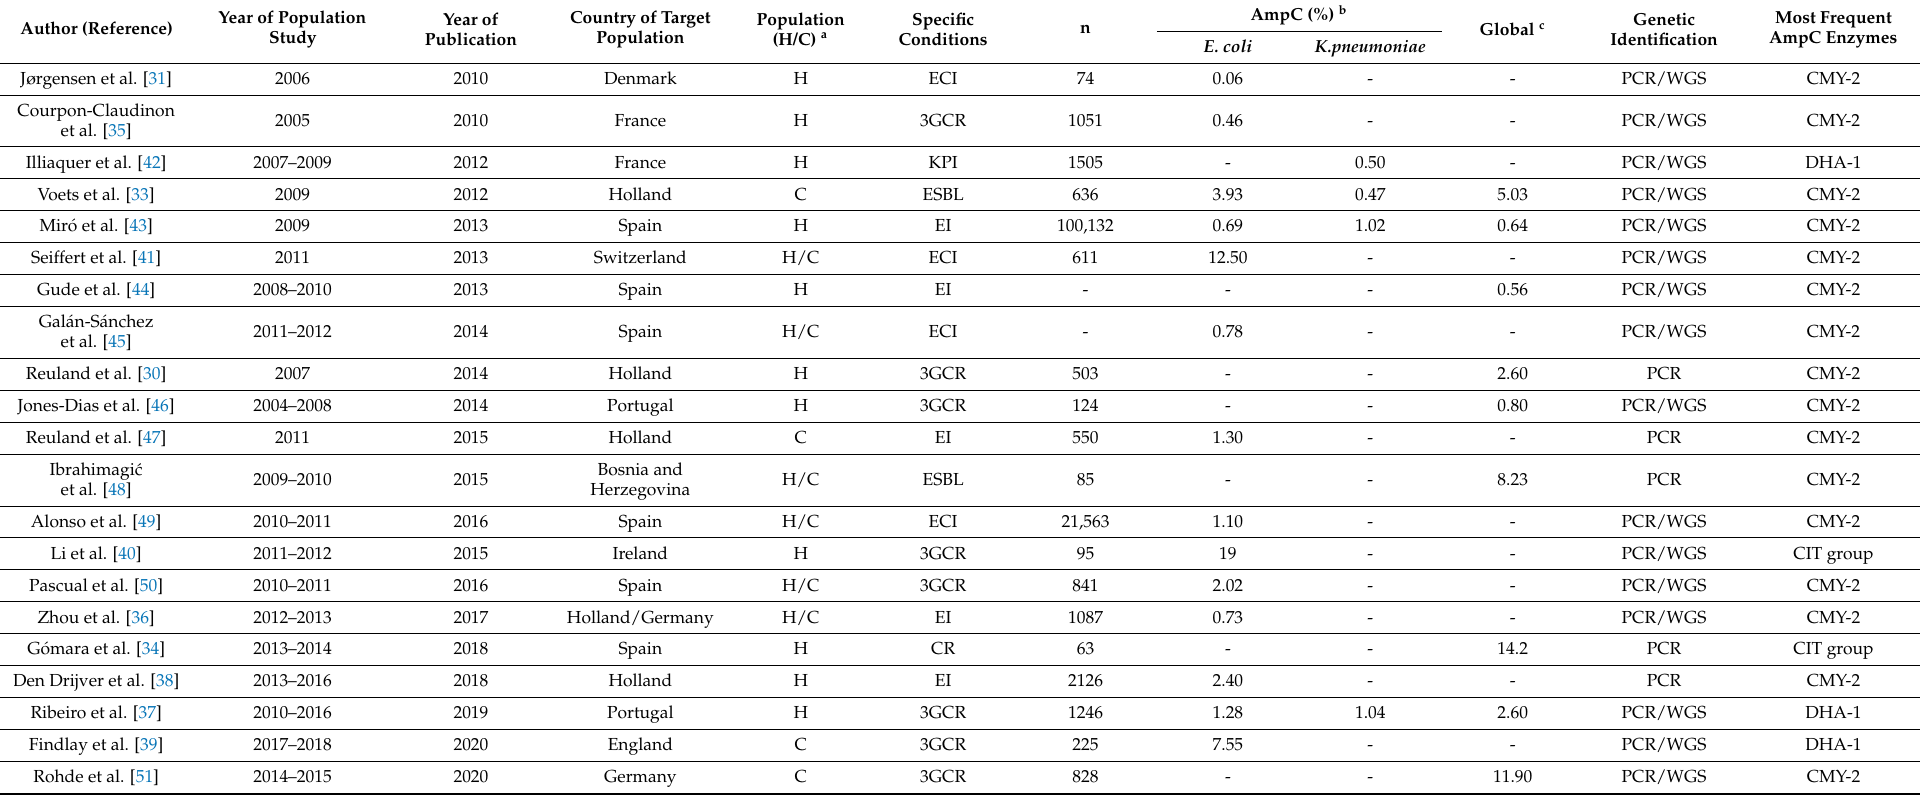
Table 2. Epidemiology of pAmpC-BLs in Europe